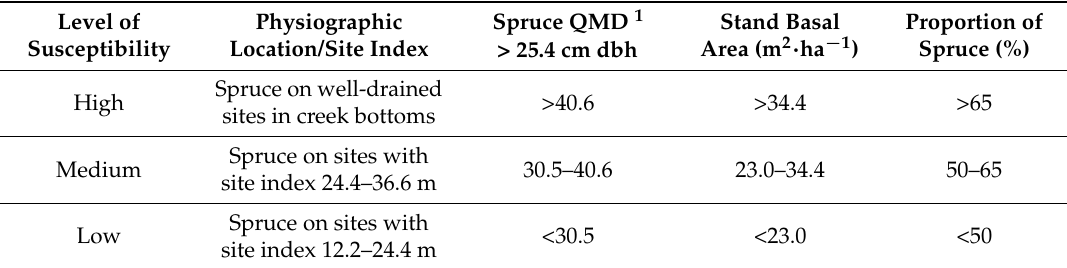
Table 2. Important elements of stand composition and structure associated with susceptibility to spruce beetle attack (after [22]). In general, susceptibility increases with increasing size, density, and percentage of